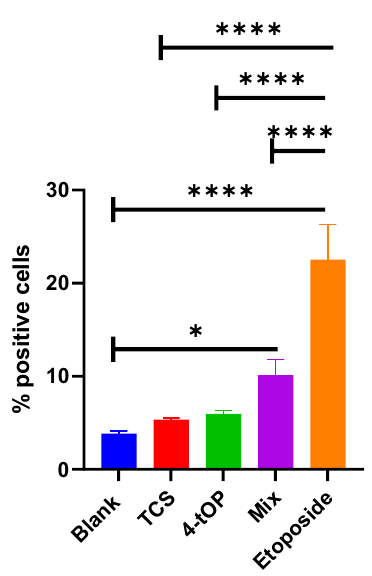
Figure 8. Proportion of cell death by necrosis after treatments. p values * = 0.048, ** = 0.0032, n = 4.